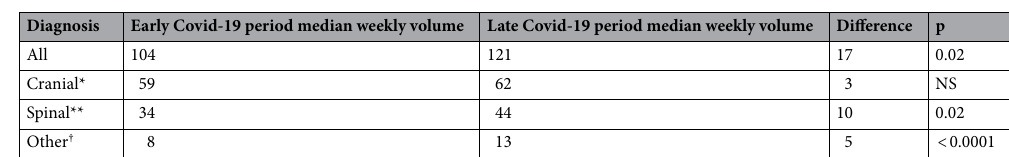
Table 1. Median weekly volumes and group-wise differences between the first 6 months of lockdown (March to August, 2020) and the same corresponding months after 1 year. All p-values are